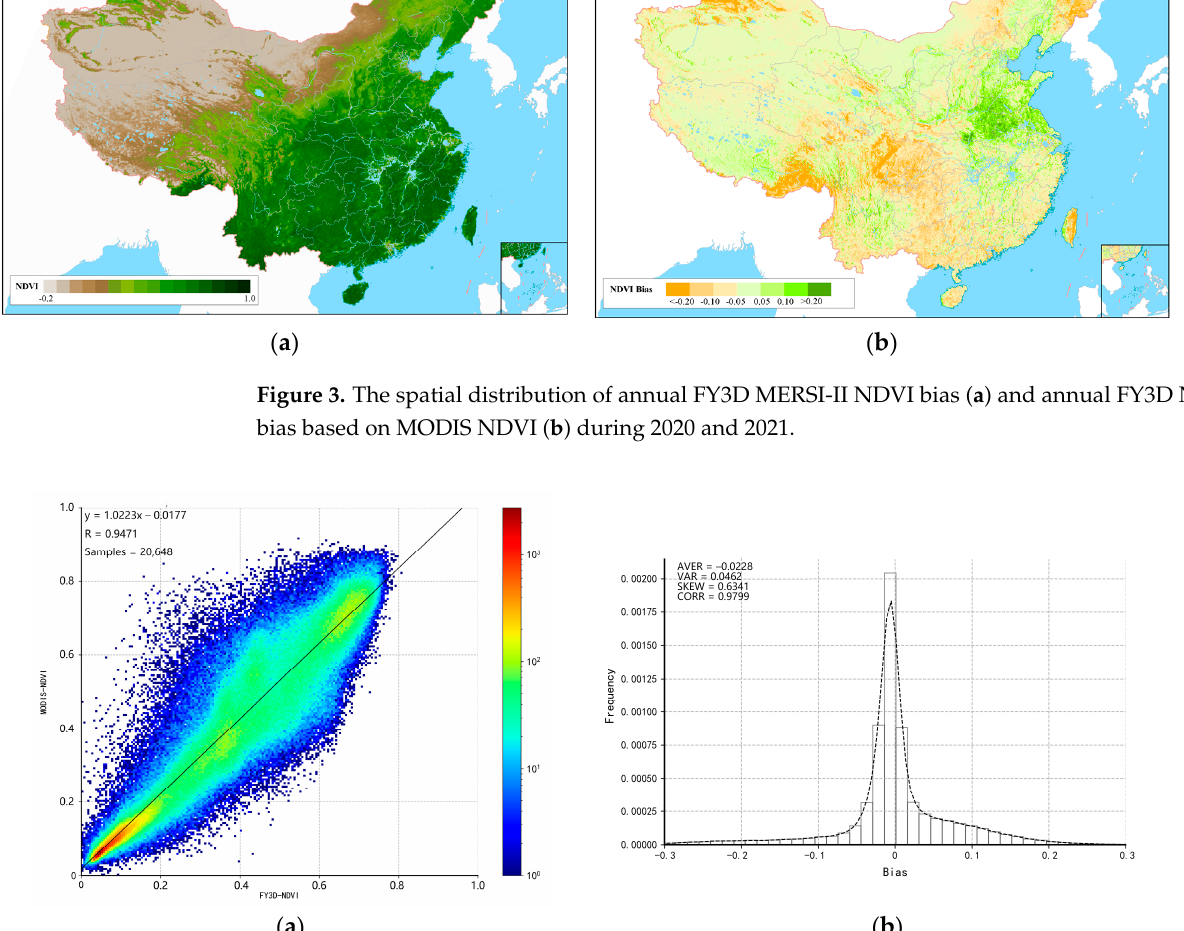
Figure 3. The spatial distribution of annual FY3D MERSI-II NDVI bias ( a ) and annual FY3D NDVI bias based on MODIS NDVI ( b ) during 2020 and 2021.